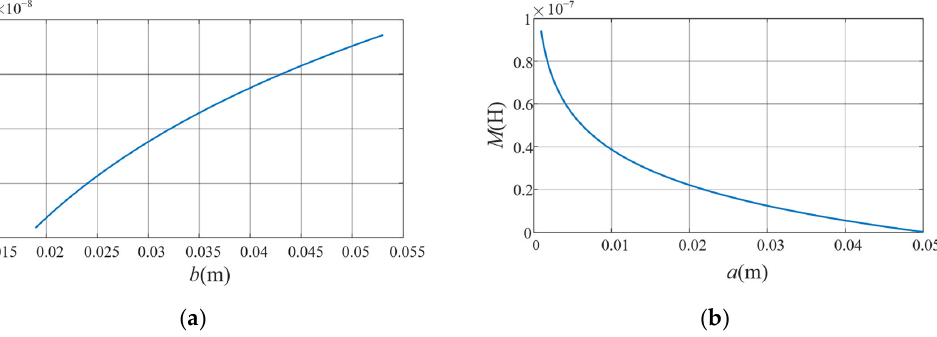
Figure 7. Influence of single parameter change on mutual inductance. ( a ) Variation curve of mutual inductance coefficient with outer diameter b . ( b ) Variation curve of mutual inductance with inner diameter a.